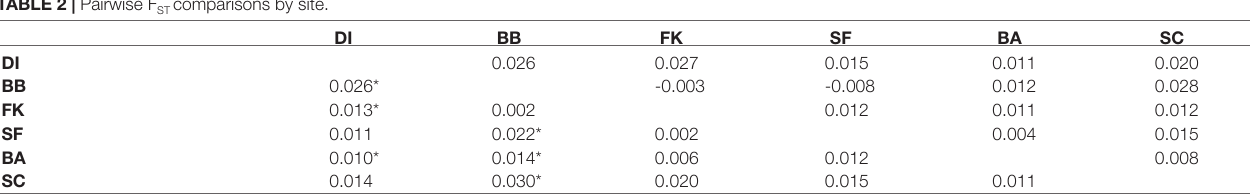
TABLE 2 | Pairwise F ST comparisons by site.